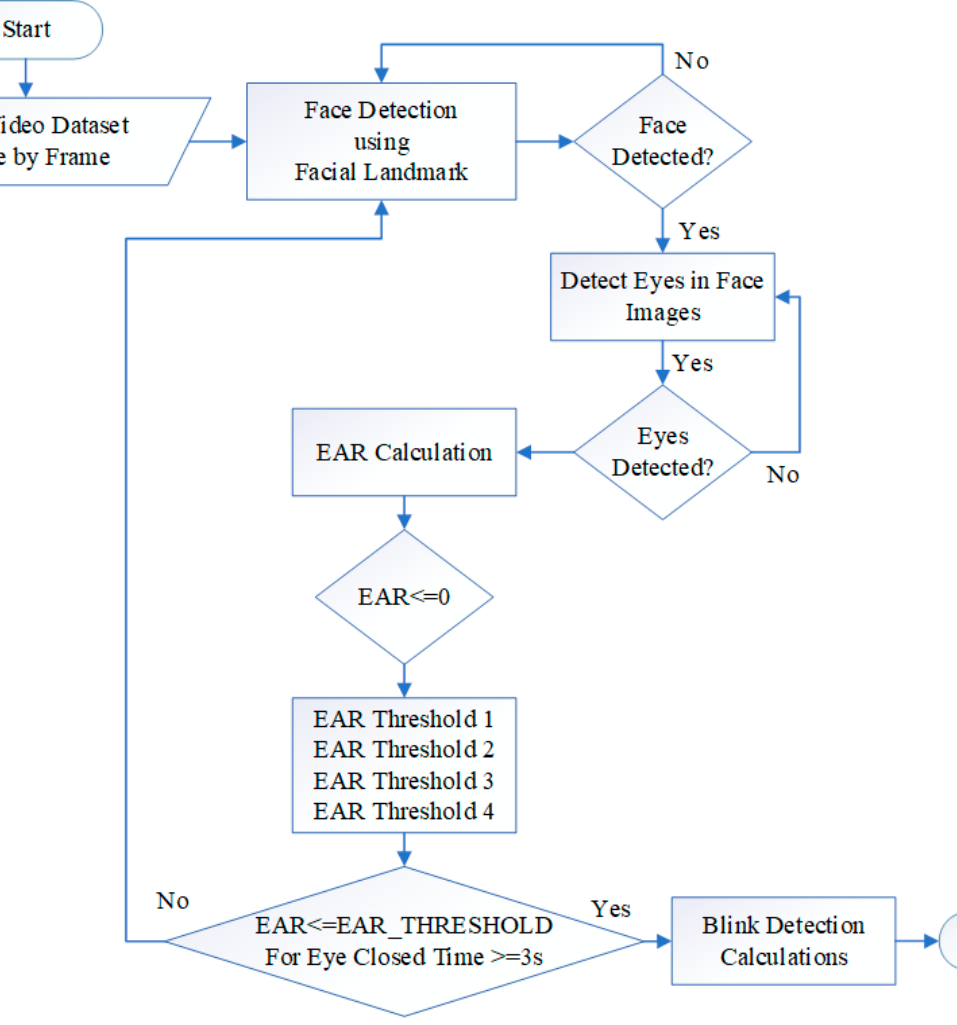
Figure 5. Eye blink detection flowchart.